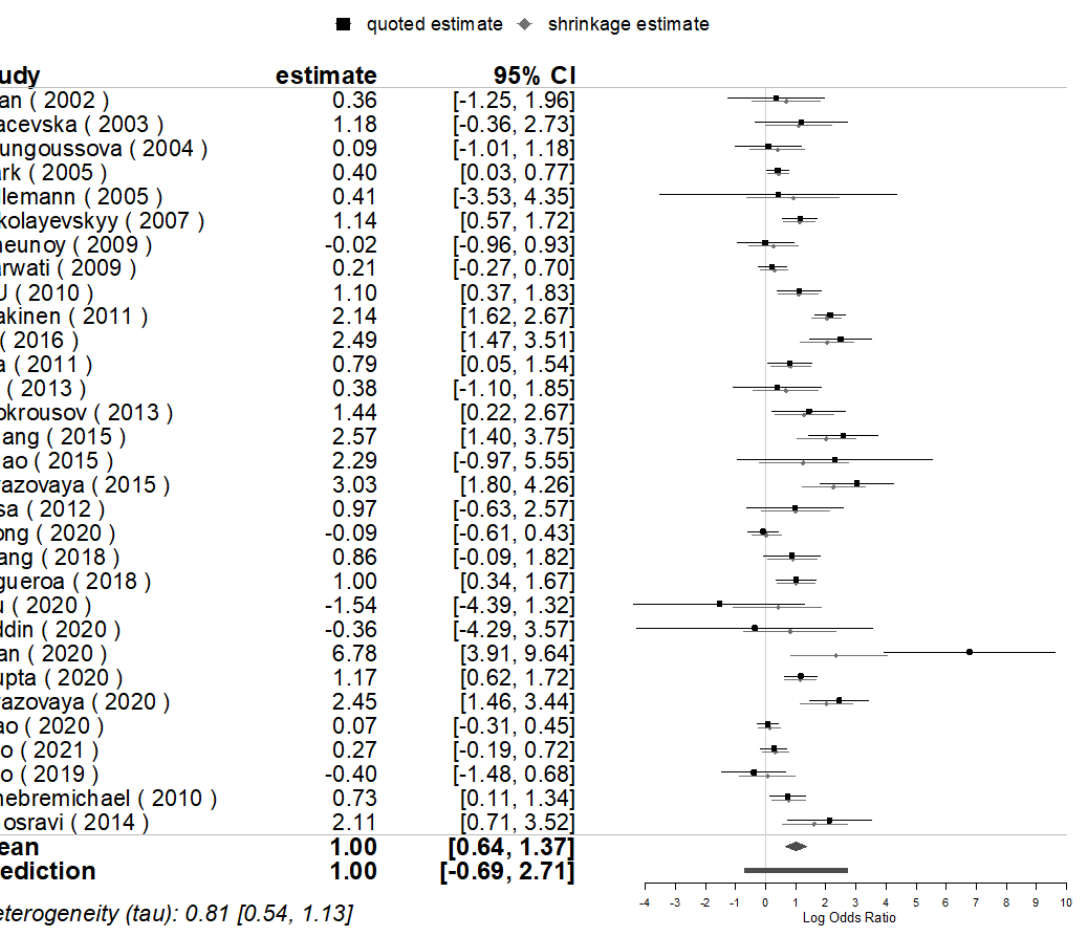
Figure 3. BMA for the mutations of rpoB in Beijing and Non-Beijing Strains (CI: confidence interval; BJ: Beijing strain; Non-BJ: non-Beijing strain).